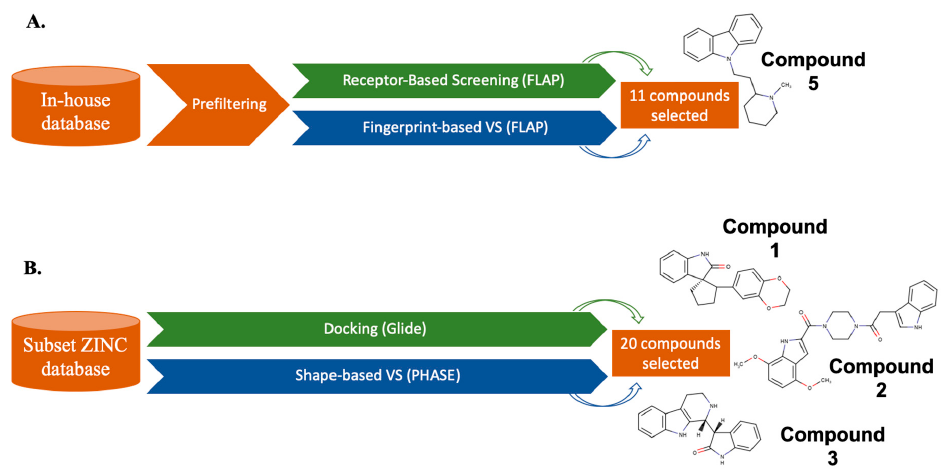
Figure 4. Schematic representation of two parallel VS processes (LB and SB methods are highlighted in blue and green, respectively). ( A ) Parallel application of LB (fingerprint similarity search) followed by SB (pharmacophoric receptor-based screening). FLAP, which allows ligand-ligand and ligand-protein similarity assays, was used for both approaches. The most active compound exhibited an IC 50 in the micromolar range. ( B ) Parallel VS over a ZINC database subset. Glide was run for SB and PHASE for LB. Among the 20 hits selected, three compounds showed activity in the micromolar range.